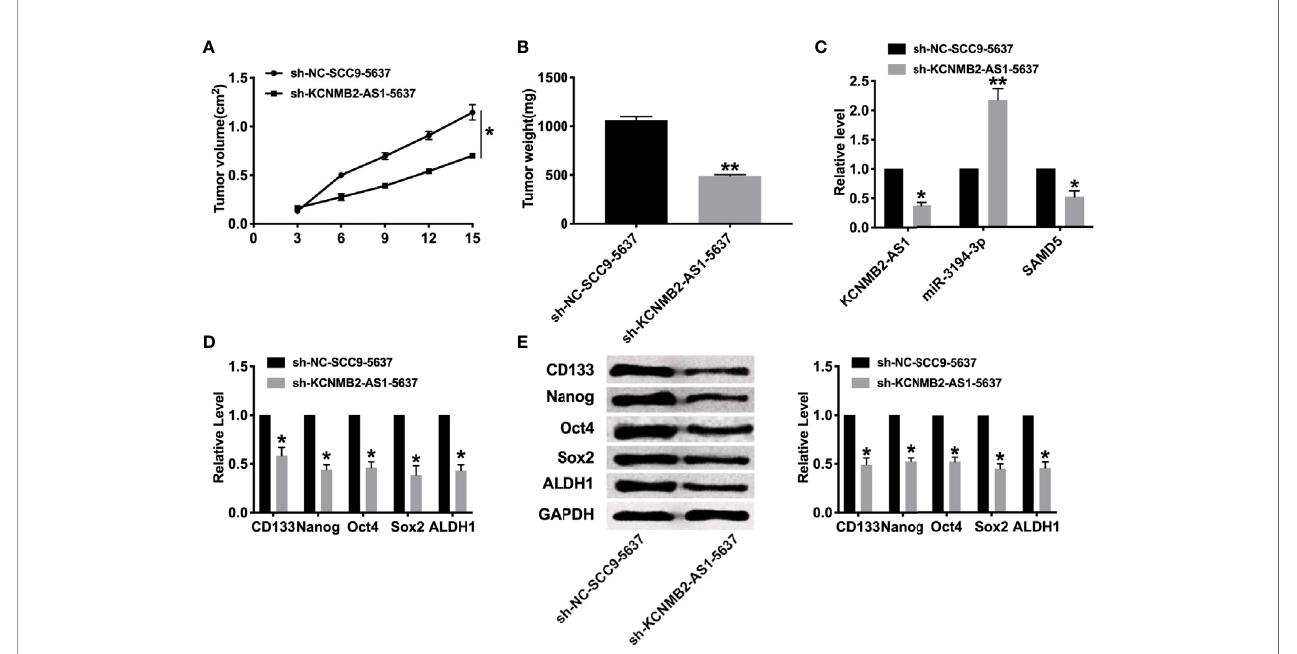
FIGURE 6 | Effect of KCNMB2-AS1 on tumor growth by in vivo . (A) Tumor volume was measured and calculated. n = 15. (B) Effect of KCNMB2-AS1 on tumor growth by in vivo tumor formation experiment. n = 10. (C) The expression of KCNMB2-AS1, miR-3194-3p, and SAMD5. n = 6. (D) The mRNA level of CD133, Nanog, Oct4, Sox2, and ALDH1 was detected by RT-PCR. n = 10. (E) The protein level of CD133, Nanog, Oct4, Sox2, and ALDH1 was detected by western blot. n = 6. * P < 0.05, ** P <